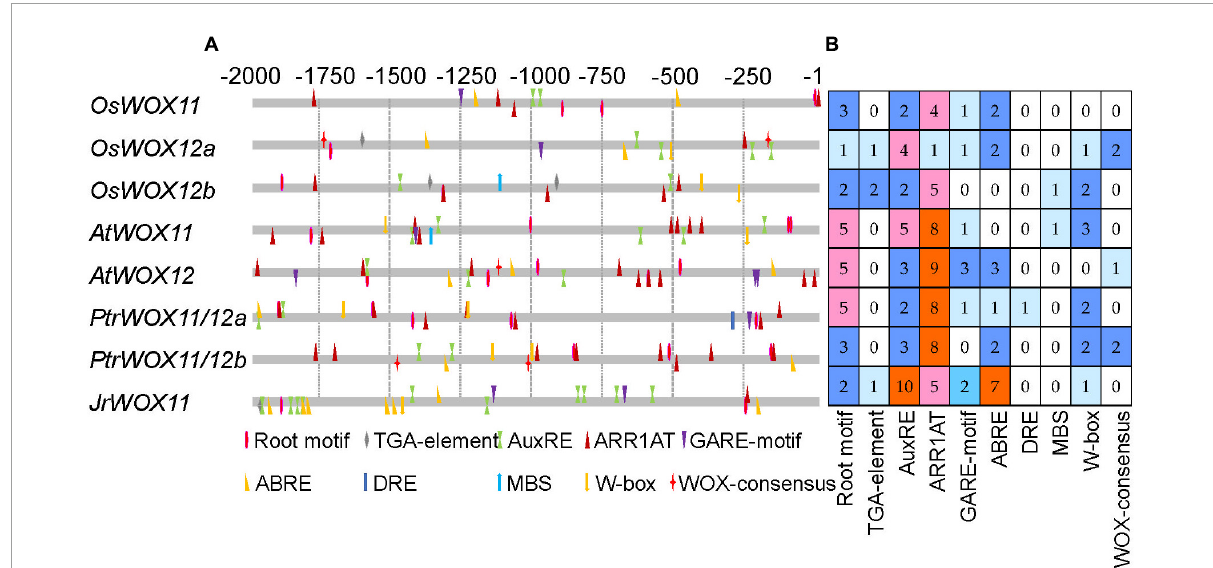
FIGURE2 The cis -element distribution and number analysis of the promoter region of WOX11/12 genes in Oryza sativa , Arabidopsis thaliana , Populus trichocarpa , and Juglans hindsii × Juglans regia cv. “ZNS.” (A) The position of the cis -element in the upstream 2,000 bp region of WOX11/12 genes. (B) The number of each cis